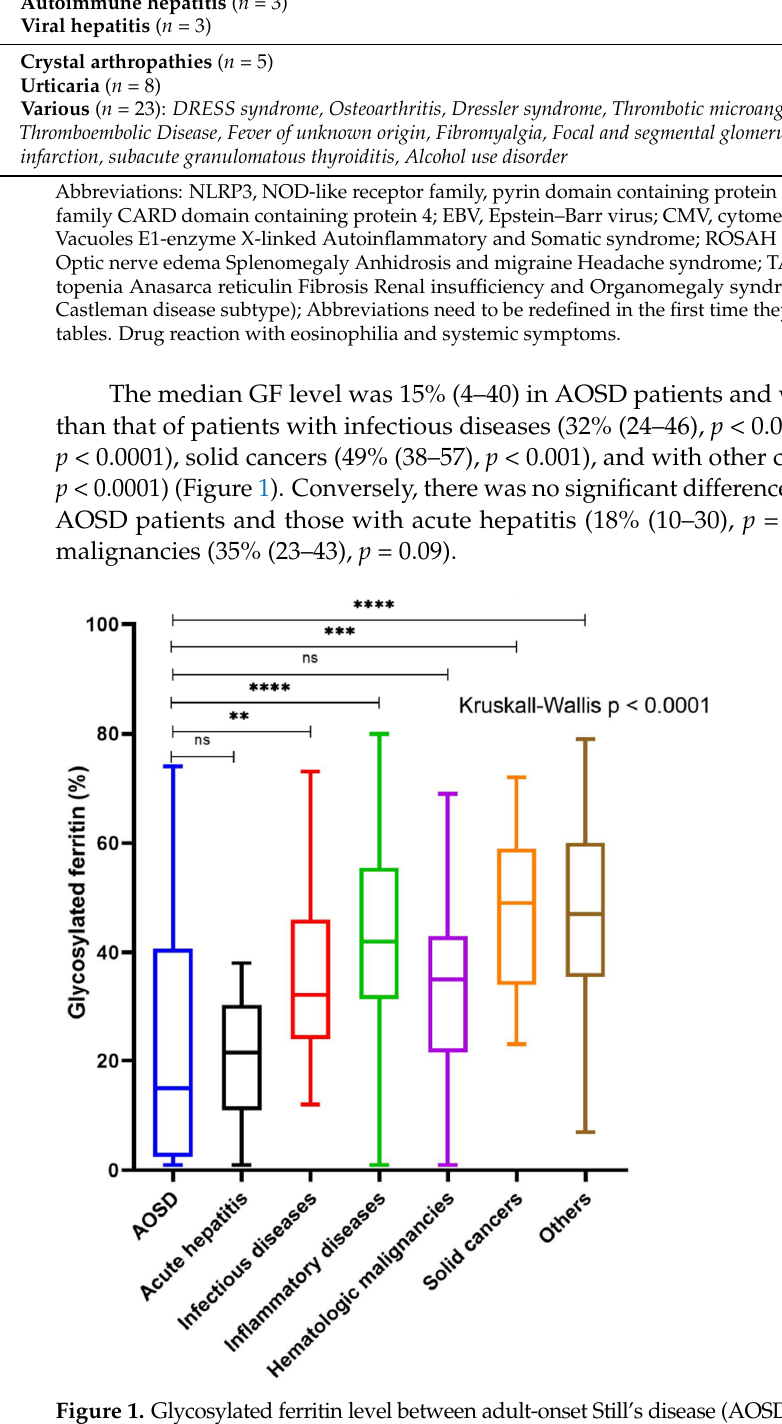
Figure 1. Glycosylated ferritin level between adult-onset Still’s disease (AOSD) and controls accord- ing to the different etiological groups. Abbreviations: ** p < 0.01; *** p < 0.001; **** p < 0.0001; ns: not